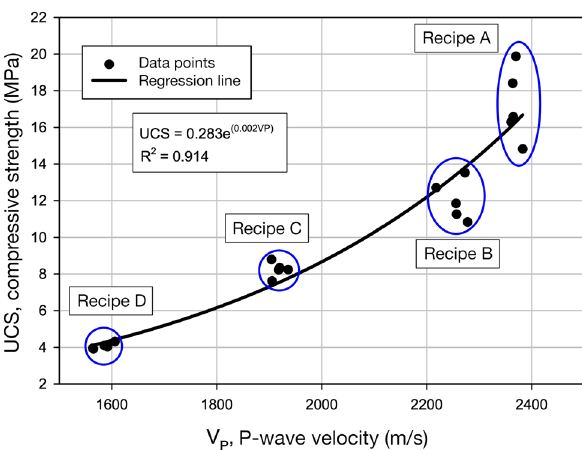
Figure 12: Compressive strength as a function of P - wave velocity for recipes A to D. Samples stored for 28 days at 20 ° C